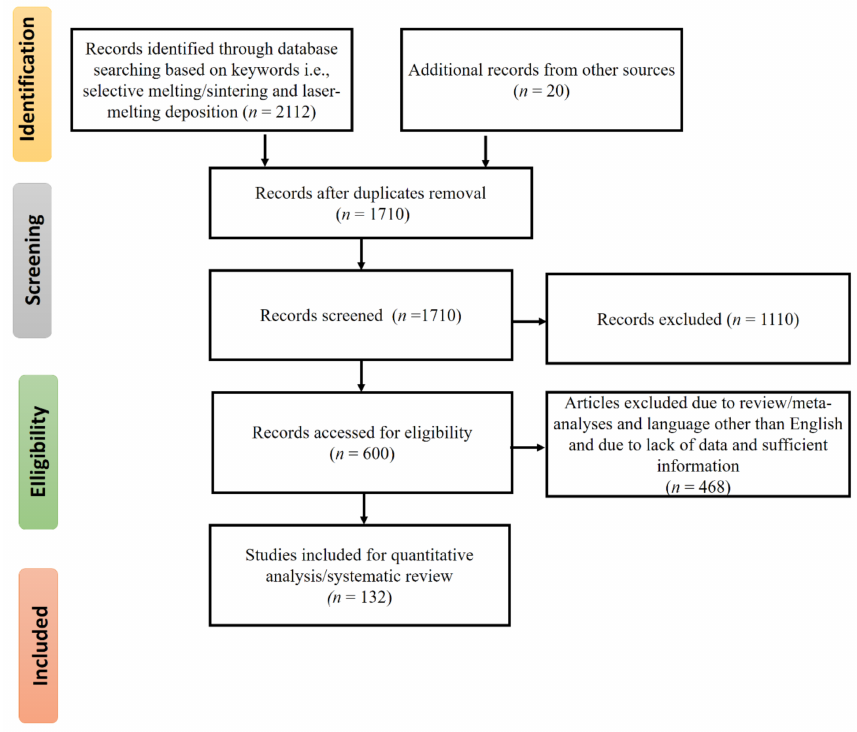
Figure 3. Review content according to PRISMA guidelines.